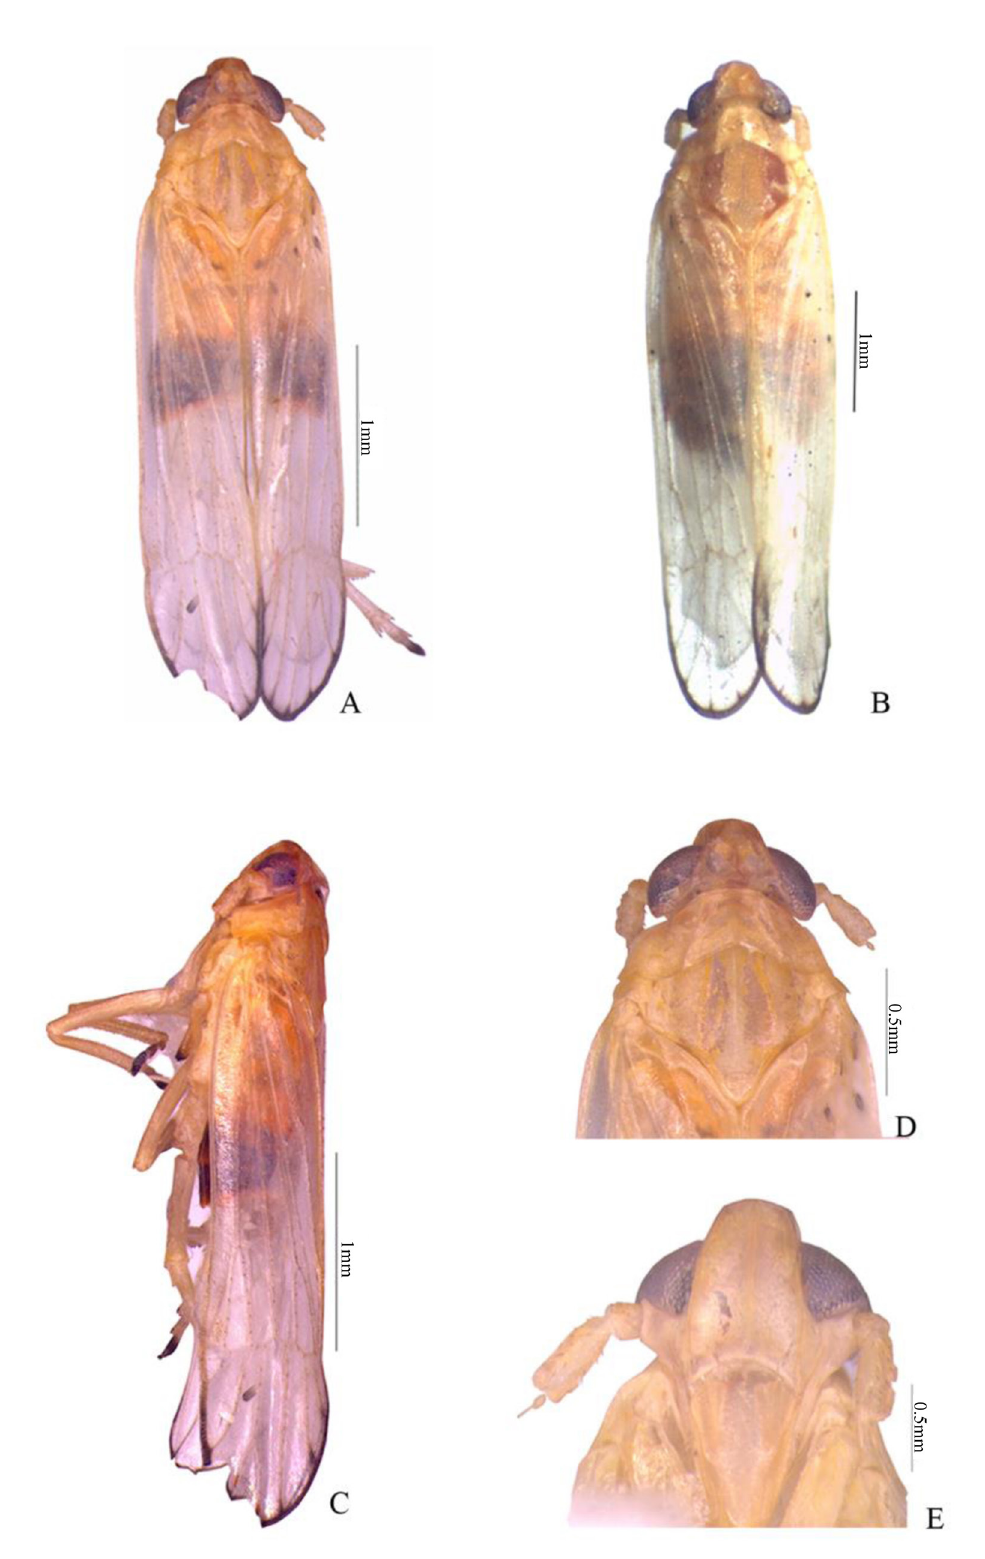
Fig. 3. Eoeurysa sagittaria sp. nov., habitus. A , C – D . Holotype ♂ (NPC HEMT9). B . Paratye ♀ (NPC HEMT14). A . Male habitus, dorsal view. B . Female habitus, dorsal view. C . Habitus, lateral view. D . Head, pro- and mesonotum, dorsal view. E . Head, ventral